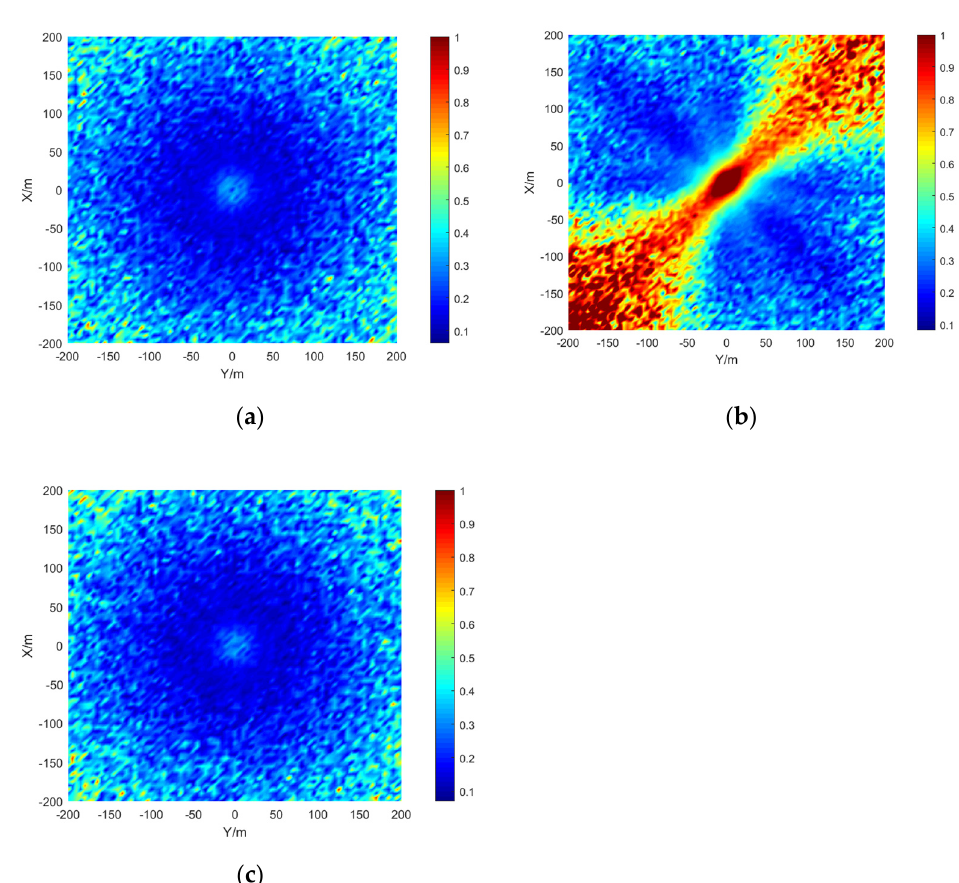
Figure 18. Positioning accuracy of planar array. ( a ) the orthogonal 8-element array. ( b ) the non- equidistant quaternary array ( c ) the orthogonal quaternary array.